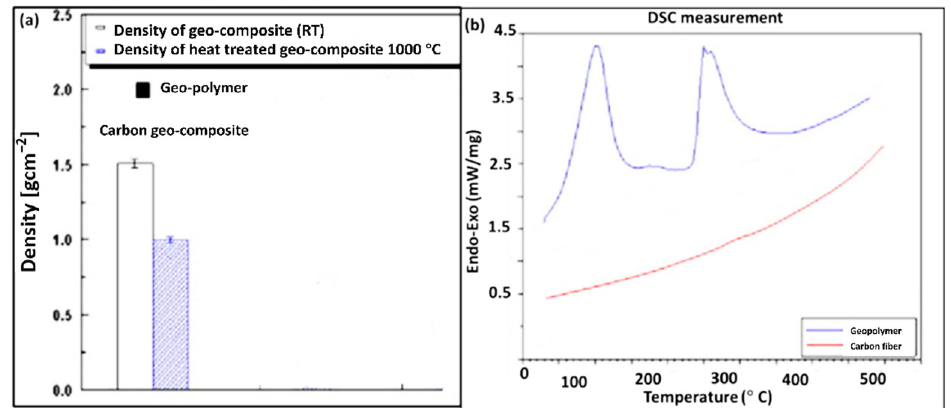
Figure 10. ( a ) Density of geopolymer (RT)and carbon fiber reinforced geopolymer composite (at room and at 1000 °C). ( b ) Thermal response of geopolymer and composite with the peak of the exothermic reaction.